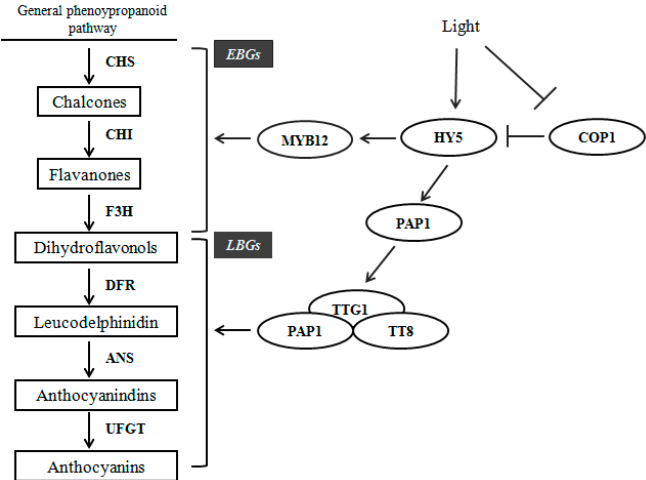
Figure 5. Anthocyanin biosynthesis pathways in turnips “Tsuda”. Enzymes encoded by flavonoid early structural genes (EBGs) and encoded by anthocyanin late structural genes (LBGs) are shown in bold. Products generated by each step are boxed. Regulatory genes are circled. These genes control structural genes expression to accumulate anthocyanins in a HY5-dependent manner under light.